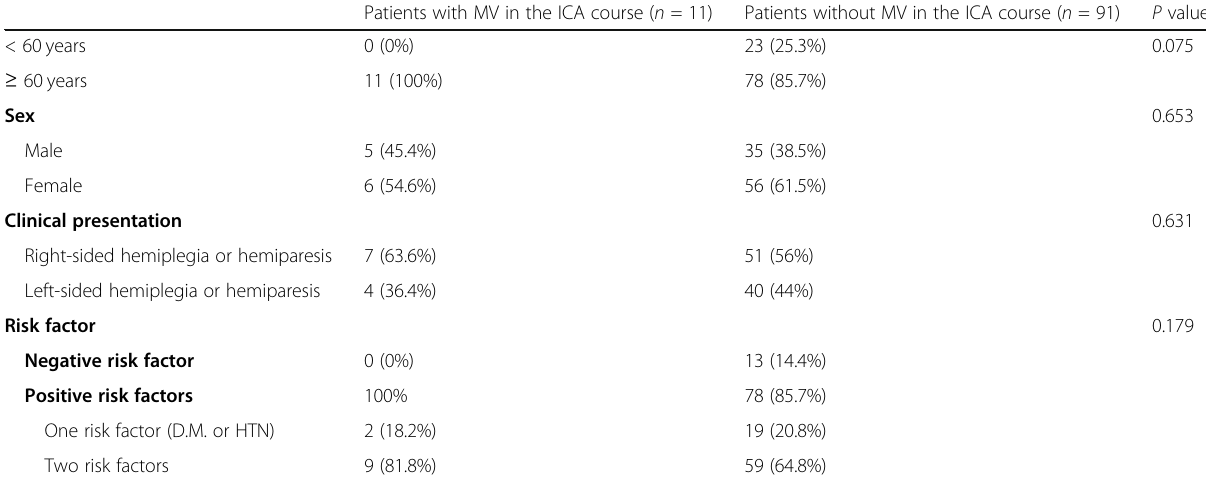
Table 1 Demographic and clinical data of ischemic stroke patients with and without internal carotid artery morphological variations Patients with MV in the ICA course ( n = 11)